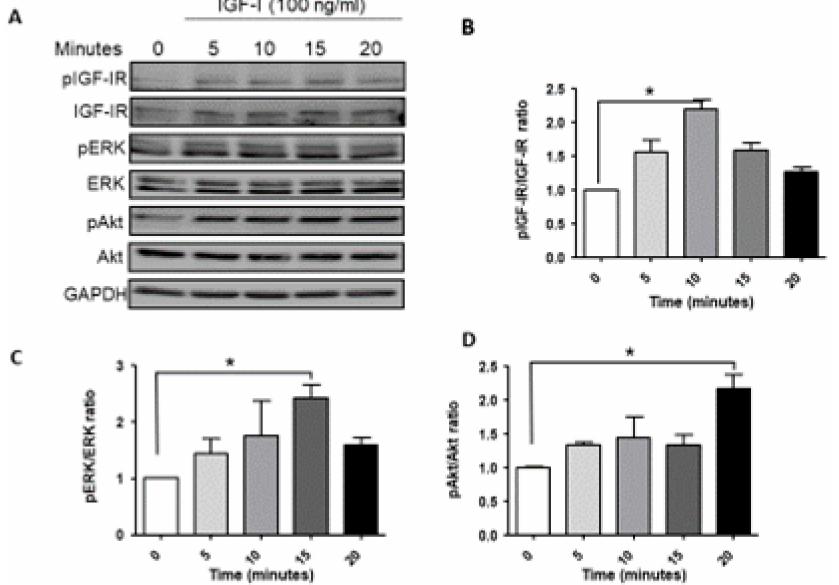
Figure 1. Ligand induced IGF-1R signaling in MDA-MB-231 cells. Cells were serum starved for 24 h and then stimulated with 100 ng/mL IGF-1 for the indicated time intervals. Shown in ( A ) is a representative Western blot of the IGF-IR and downstream signaling mediators following IGF-1 stimulation. Shown in the bar graphs ( B – D ) are the mean (and SE (standard error)) of 3 experiments expressed as pIGF-1R/IGF-1R, pERK/ERK, and pAkt/Akt ratios, respectively, normalized to the levels of unstimulated cells that were assigned a value of 1. * p <